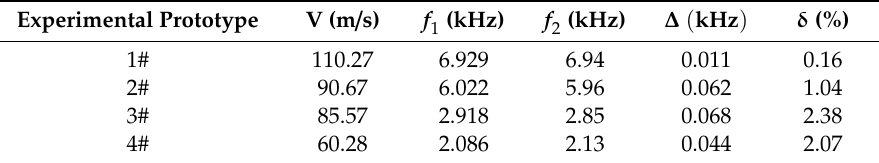
Table 3. Actual and theoretical resonance frequency values.